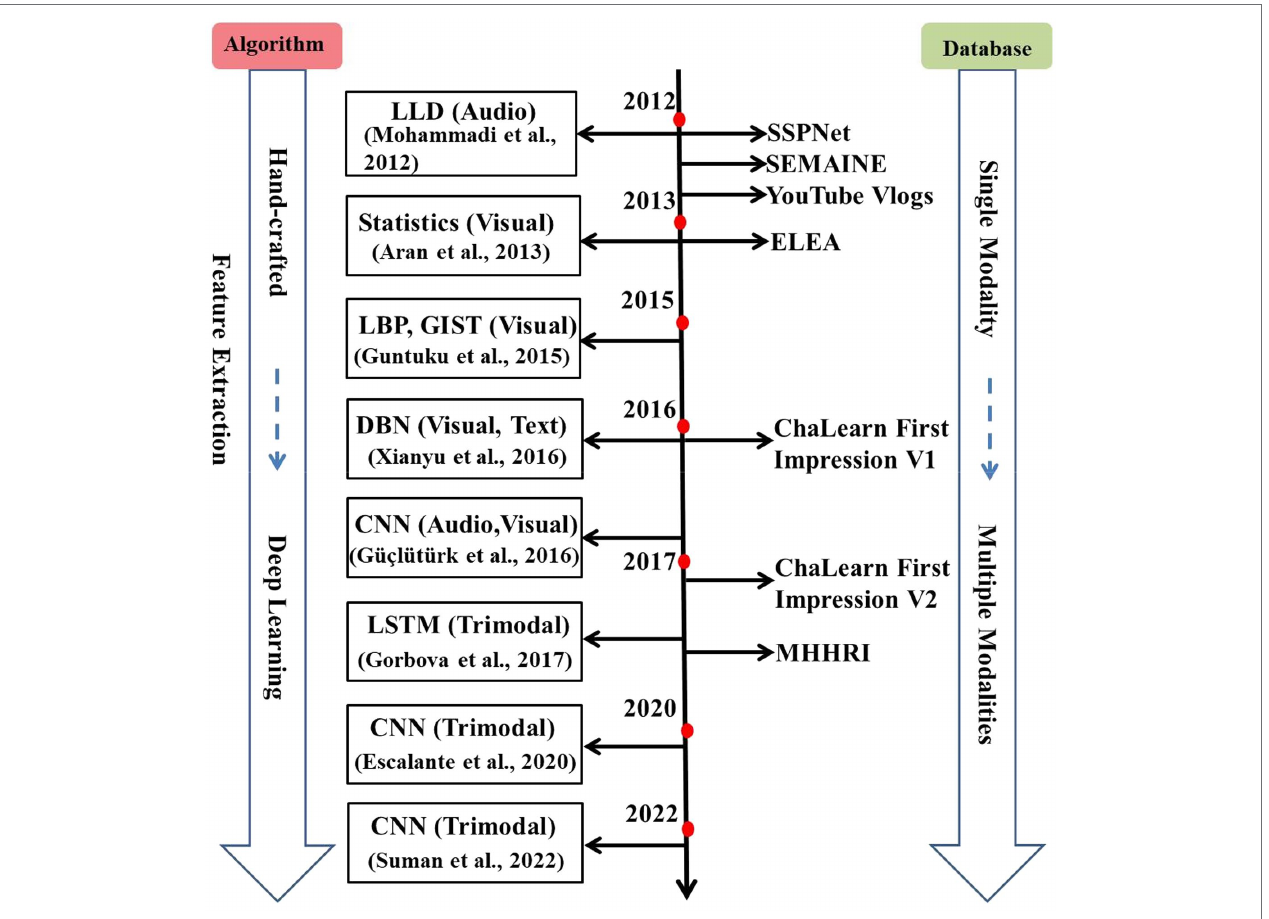
FIGURE 1 | The evolution of personality trait recognition with feature extraction algorithms and databases. From 2012 to 2022, feature extraction algorithms have changed from hand-crafted to deep learning. Meanwhile, the developed databases have evolved from single modality (audio or visual) to multiple modalities (audio, visual, text,